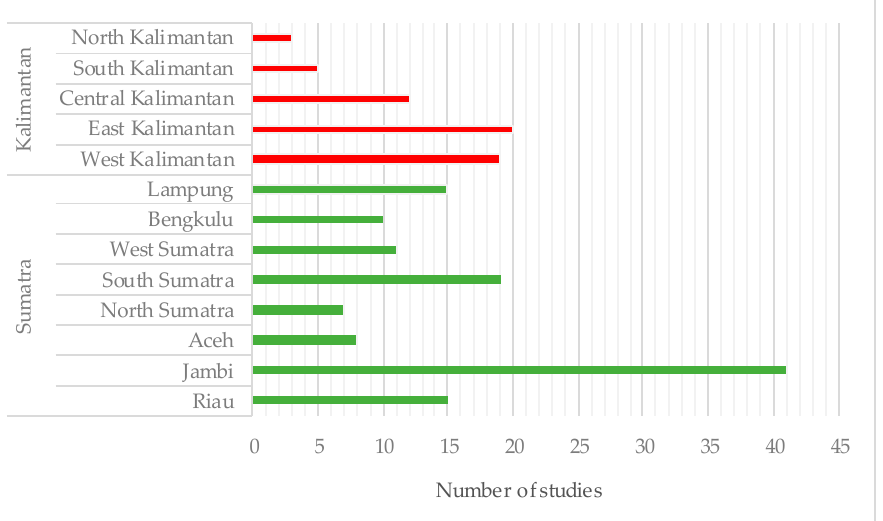
Figure 3. Distribution of studies by province.